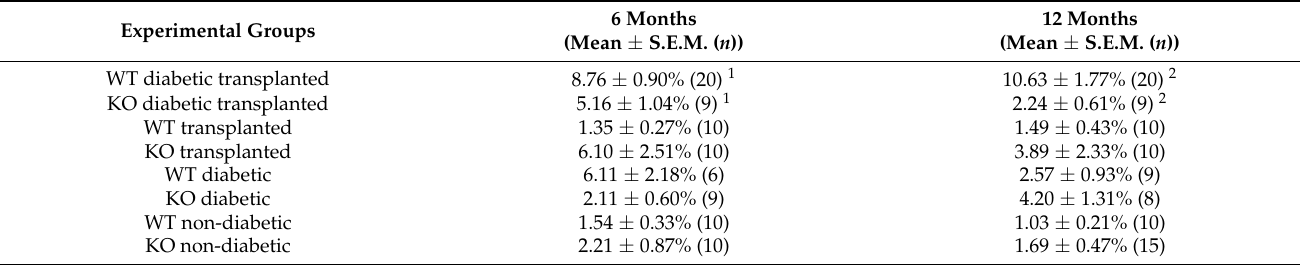
Table 2. Proliferation in normal liver tissue. Proliferative activity as BrdU-LI of normal liver parenchyma in wild type (WT) and ChREBP-knockout (KO) mice is shown. Comparison between WT and KO in each group. Experimental